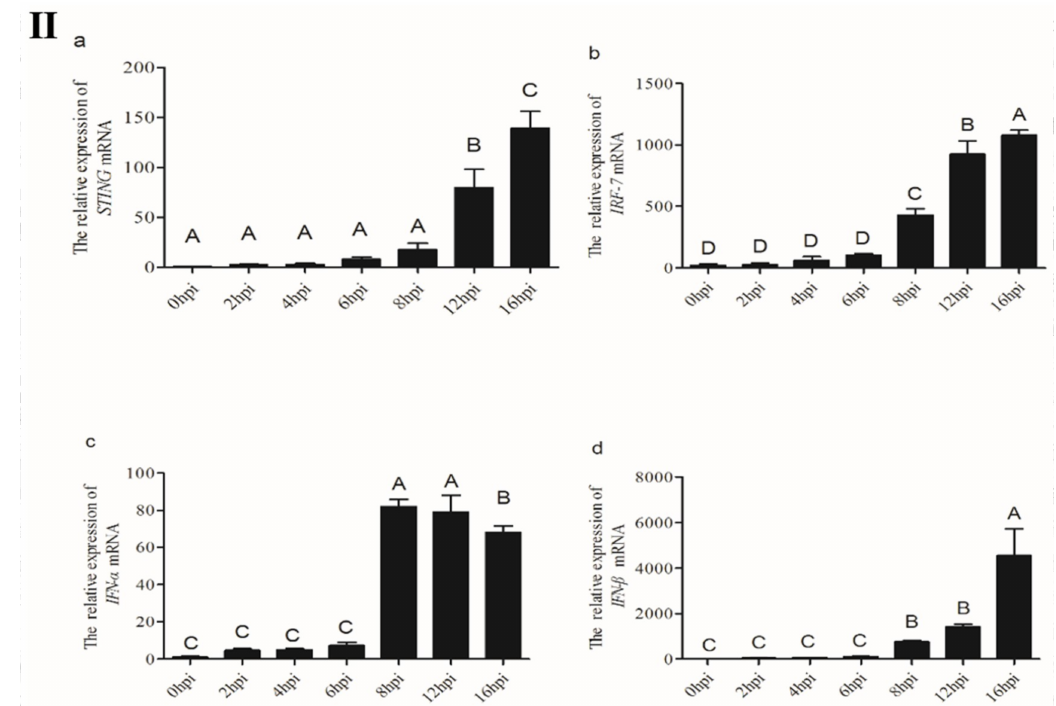
Figure 7. The expression levels of STING and its down-stream genes in CEFs after infection with NDV. (I) CEFs were infected with different MOIs of NDV and then analyzed for the expression levels of STING and its down-stream genes by real-time PCR. (II) After infection with NDV, the expression levels of STING and its down-stream genes in CEFs were analyzed at different points. All data shown are the mean ± SD ( n = 3) and subjected into one-way ANOVA to identify differences between groups. Columns sharing completely different capital letters show significant difference ( p <